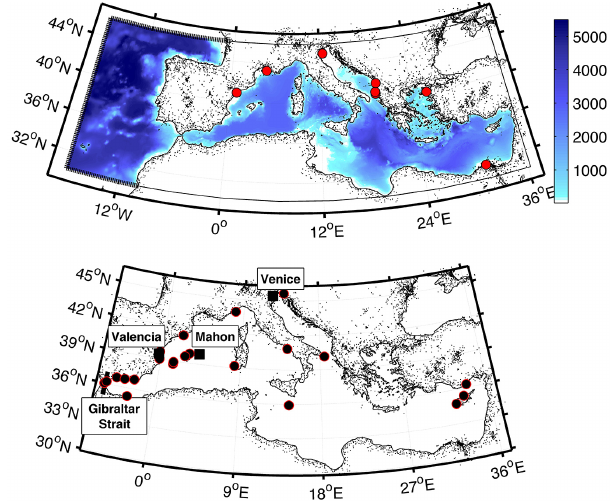
Figure 1. Upper panel: model domain. Bold dashed lines in the At- lantic indicate the location of the lateral boundaries of the model. Red circles indicate river locations and Dardanelles inflow. Bottom panel: black circles indicate tide gauge positions. Dark squares indi- cate the positions of the tide gauges collecting high-frequency data. The Gibraltar Strait is also